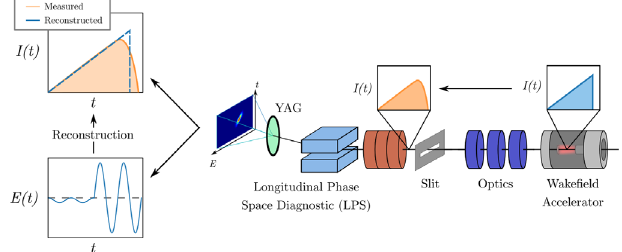
FIG. 1. Sketch of an example wakefield accelerator beamline (beam travels to the left) with a single stage wakefield accelerator and a single shot longitudinal phase space diagnostic. The reconstruction algorithm provides an accurate beam profile determination at the wakefield source, without sampling biases resulting from